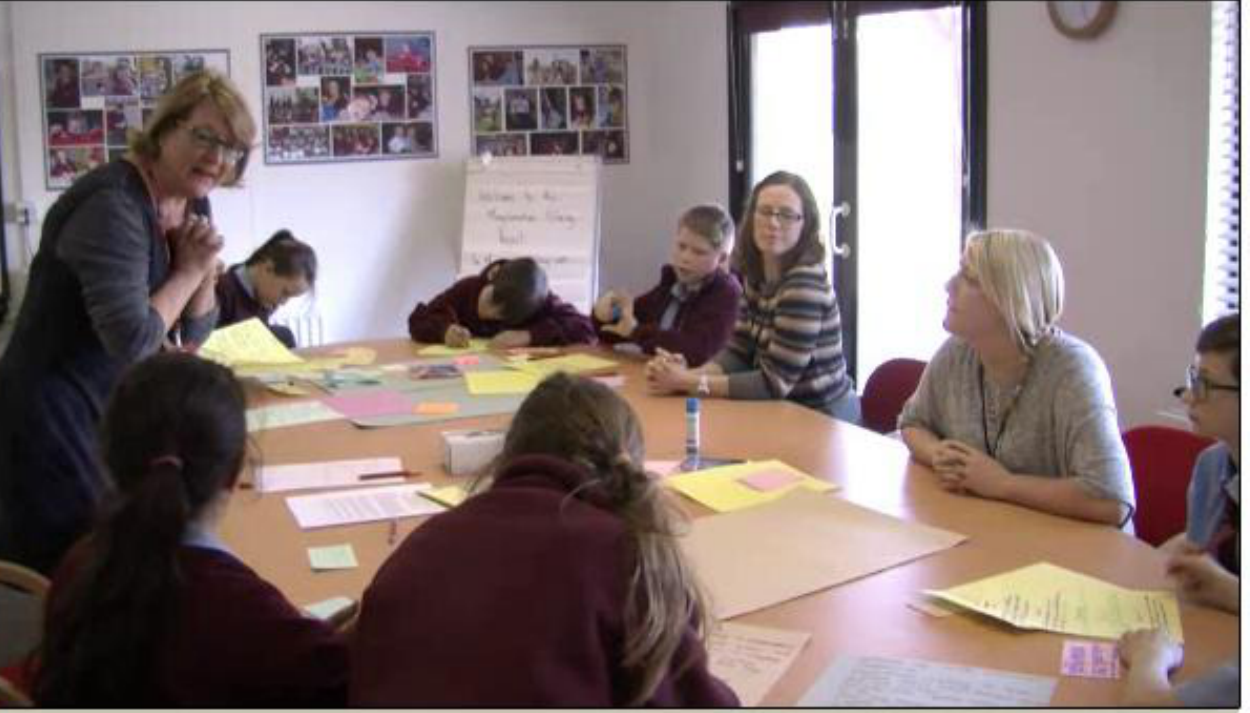
Figure 1 . The co-design workshop in